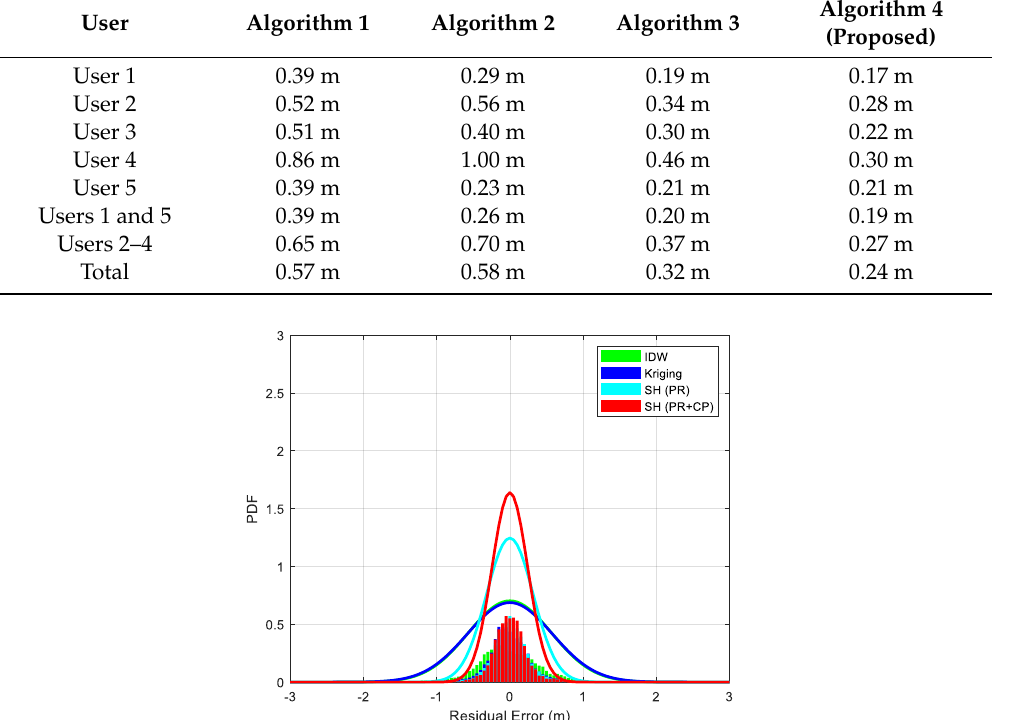
Table 3. RMS of the residual error (real data, 1 September 2014). Users are grouped into two groups depending on their position. Users 1 and 5 were located relatively inward, and Users 2–4 were located outward.